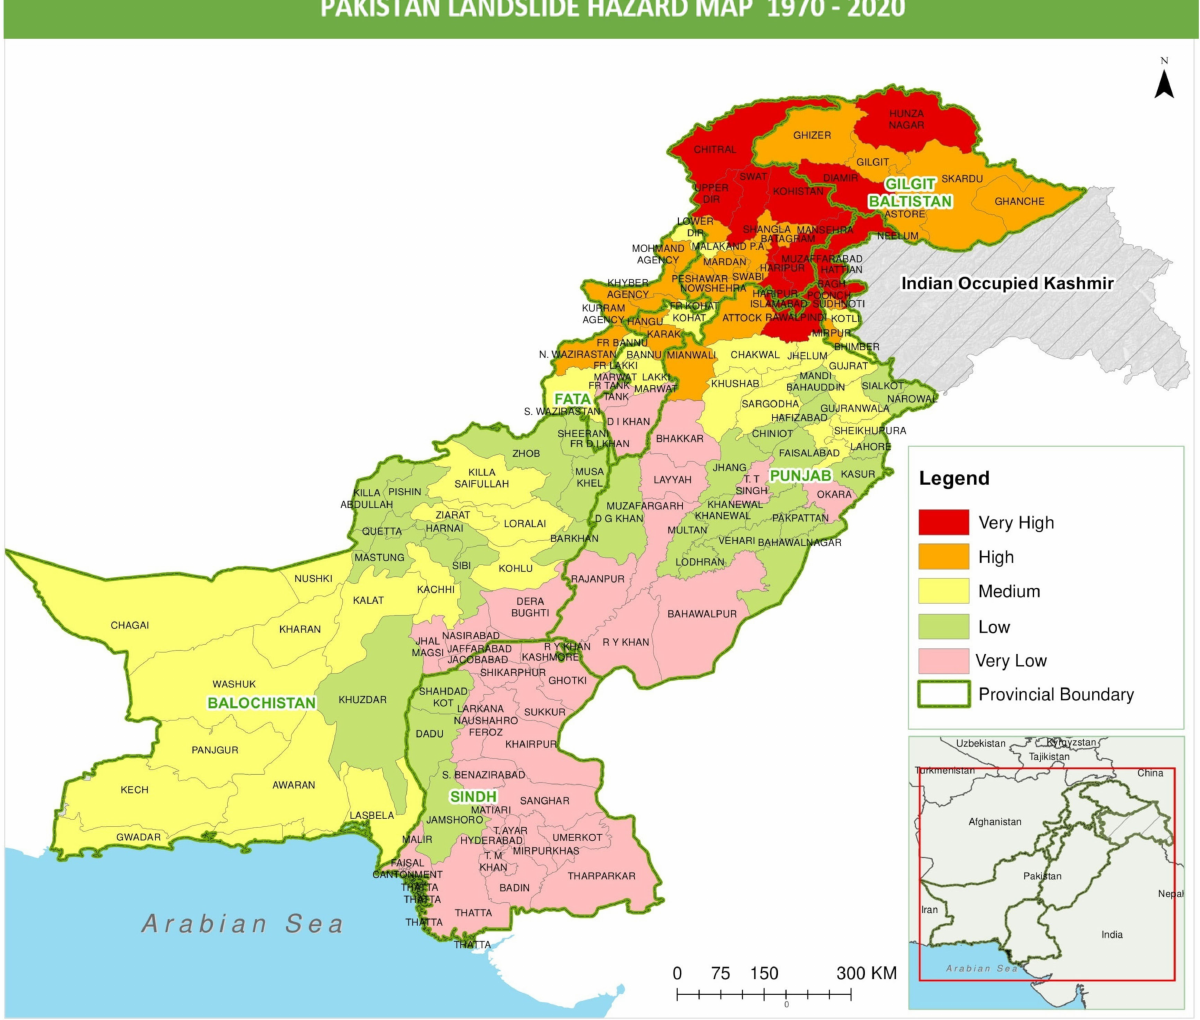
Figure 10. Pakistan Landslide Hazard Map 1970–2020 showing the intensity of landslides at district